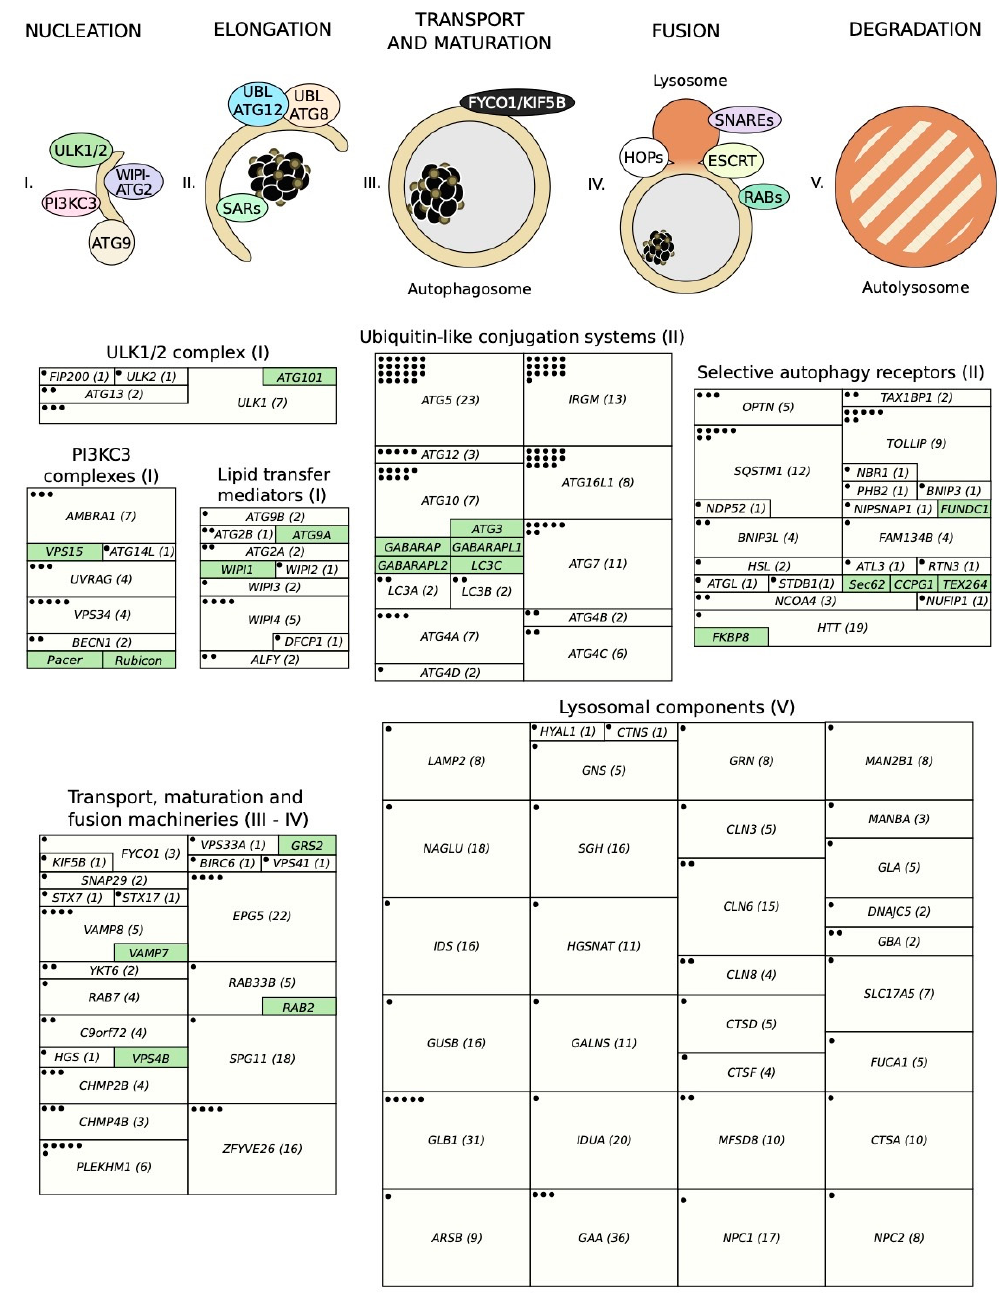
Figure 2. Schematic view of the incidence of clinically relevant single nucleotide polymorphisms (SNPs) in genes throughout the autophagosome/lysosome axis. Autophagy can be divided in different stages: ( I ) initiation and membrane nucleation, (II) membrane expansion, ( III ) autophagosome maturation and transport, ( IV ) autophagosome-lysosome fusion and ( V ) lysosomal degradation. Pathological variants have been found in genes involved in all of the steps. Boxes show the genes whose products participate in each of these stages. The size of the boxes is proportional to the number of pathological SNPs found for each of the genes depicted. The total number of pathological SNPs found in a given gene is depicted between brackets. Each different disease linked to a determined gene is represented by a dot. Green boxes contain genes without any clinically relevant SNPs identified to date. PI3KC3, class III phosphatidylinositol 3-kinase protein complexes; UBL, ubiquitin-like conjugation system; SARs, selective autophagy receptors; HOPS, homotypic fusion and protein sorting tethering complex; ESCRT, endosomal sorting complexes required for transport.